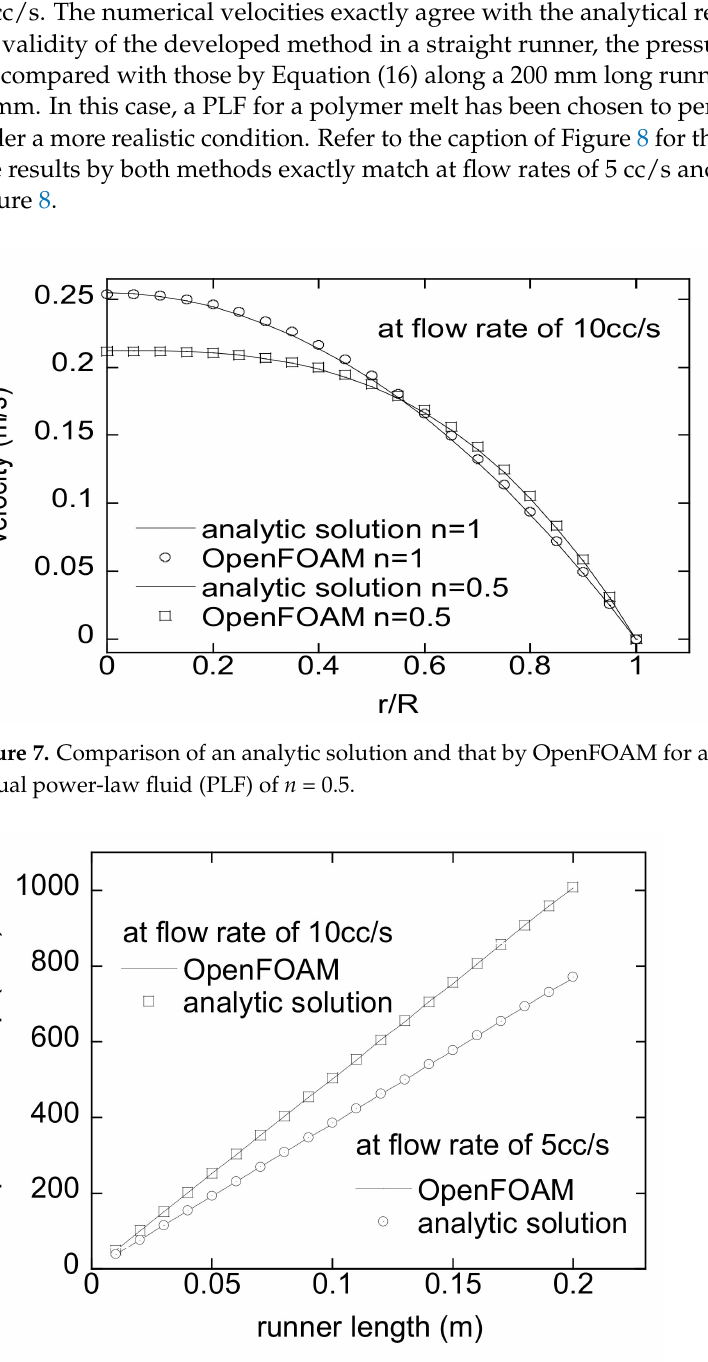
Figure 8. The pressure drop along the flow direction, OpenFOAM, and analytic solutions by Equation (13) for a PLF of n = 0.388, K = 1842.4 Pa · s n and ρ = 891.63 kg/m 3